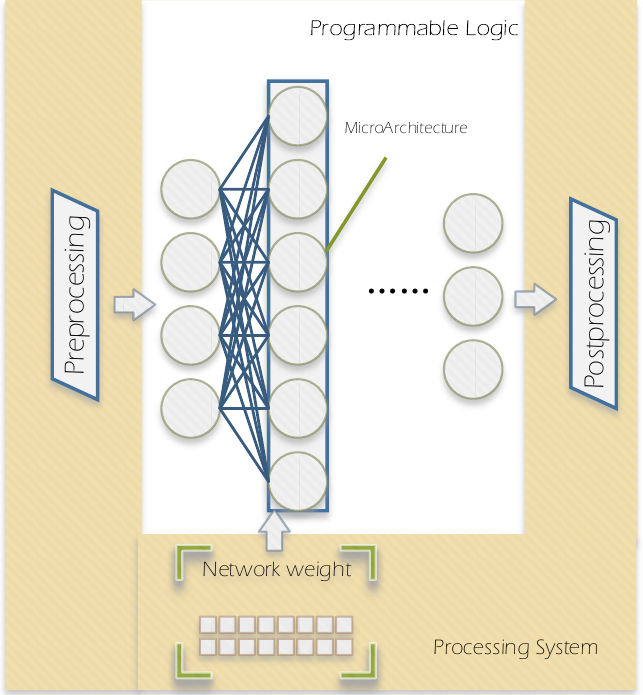
Figure 2. The programmable logic refers to programmable circuits and the processing system constitutes of one or more processing units which can not be